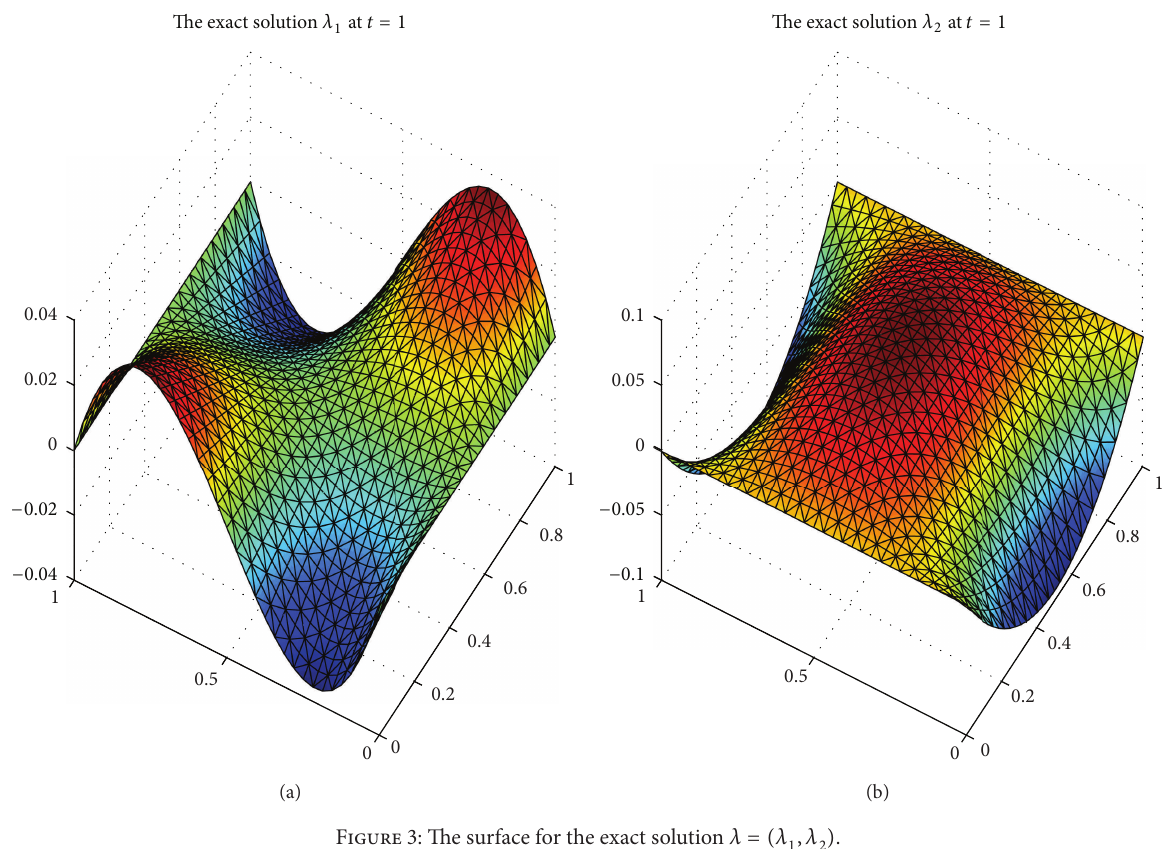
Figure 3: The surface for the exact solution 𝜆 = (𝜆 1 ,𝜆 2 ) .